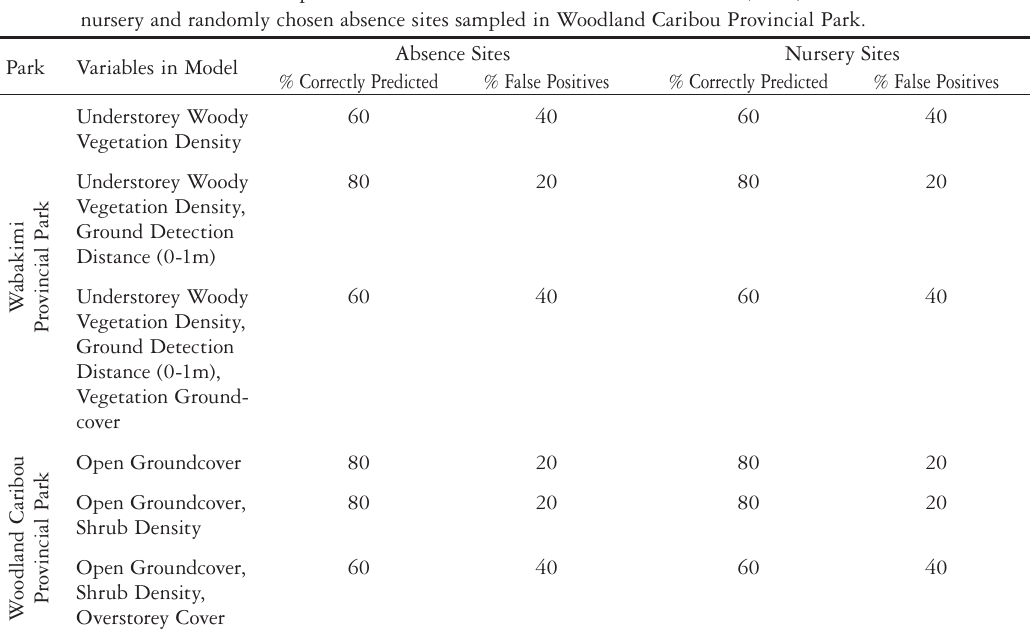
Table 3. Predictive probabilities (i.e., proportions of sites correctly or incorrectly classified) of candidate Resource Selection Function models (Table 2) based on one-third ( n =10) of the data from caribou nursery and randomly chosen absence sites sampled in Wabakimi Provincial Park and one-third ( n =10) of the data from caribou nursery and randomly chosen absence sites sampled in Woodland Caribou Provincial